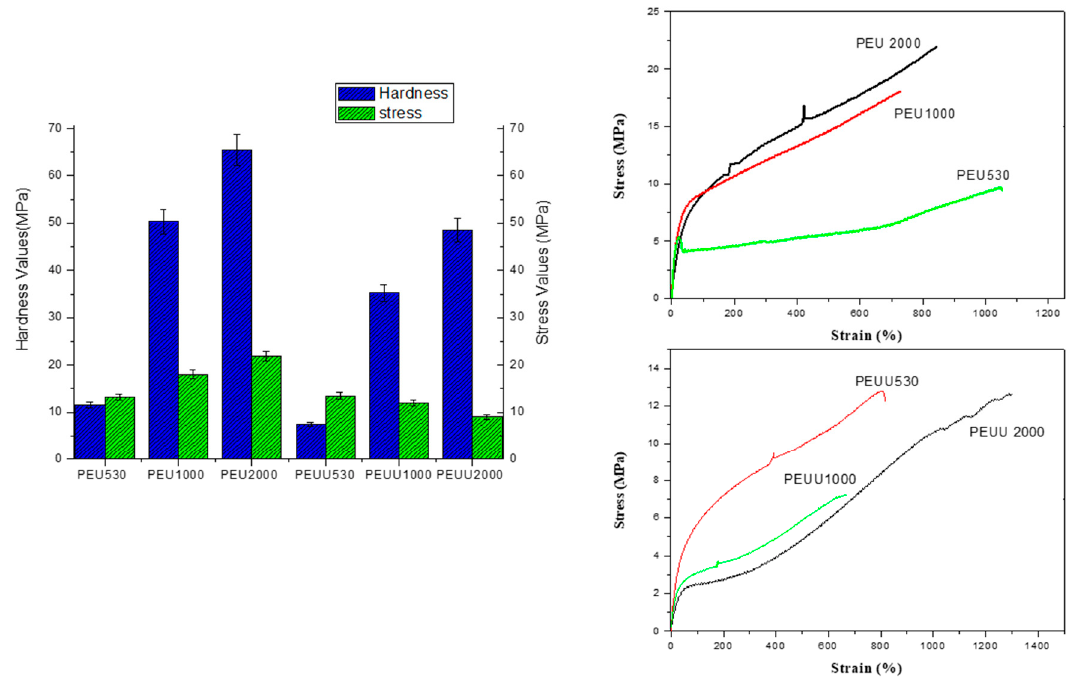
Figure 5. Stress-strain and hardness results of polymers.